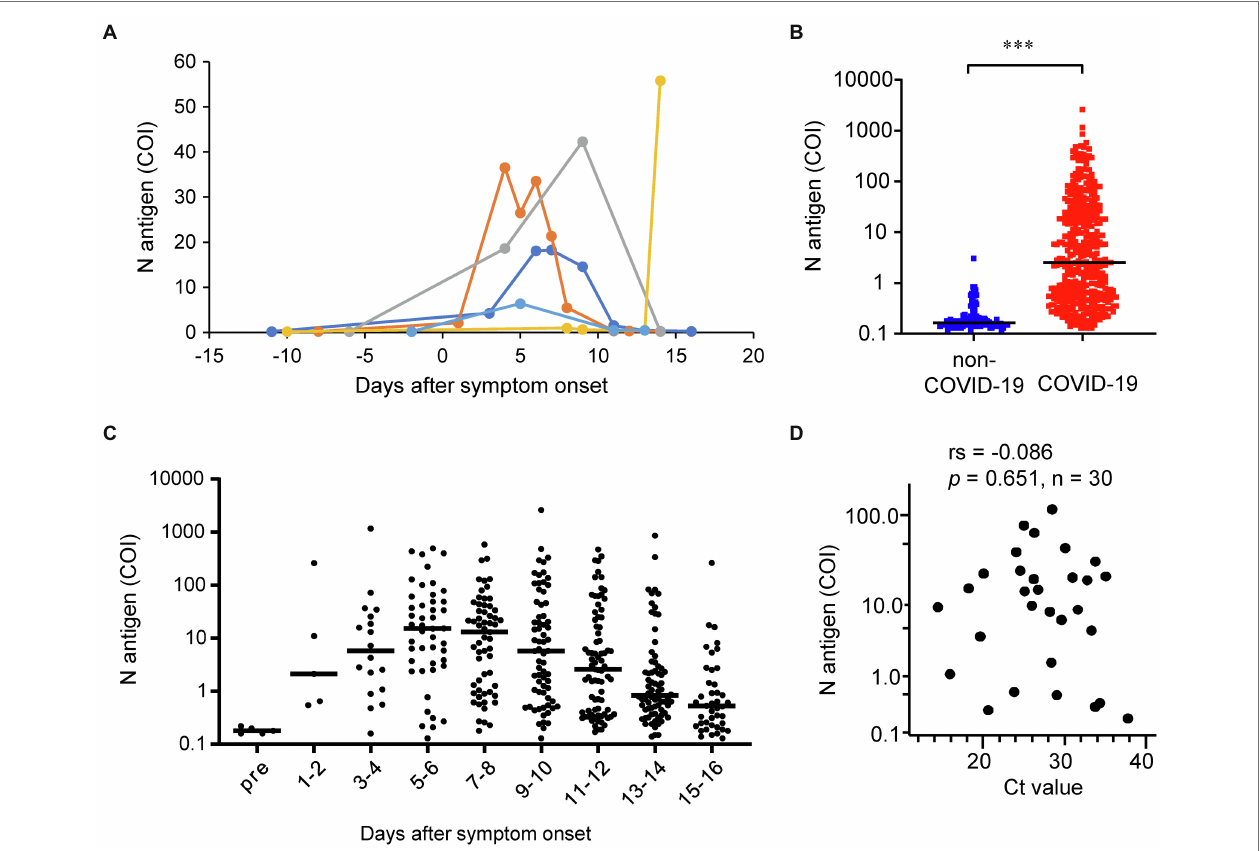
FIGURE 1 | Distributions of the serum N antigen levels. (A) The time-courses of the serum N antigen levels are shown for the five cases for whom both serum samples before and after the onset of COVID-19 symptoms were available. (B) We measured the serum N antigen levels in 391 serum samples collected from 101 COVID-19 cases and one serum sample each collected from 96 non-COVID-19 cases. *** p < 0.005 (C) The dot plots show the time-courses of the serum N antigen levels from before ( n = 5) through various time-points after ( n = 391) symptom onset. The bars show the median levels at each time point. (D) We compared the serum N antigen levels with the Ct values of SARS-CoV-2 RNA in the same subjects on the same day as the collection of serum samples ( n = 30). rs, spearman’s rank correlation